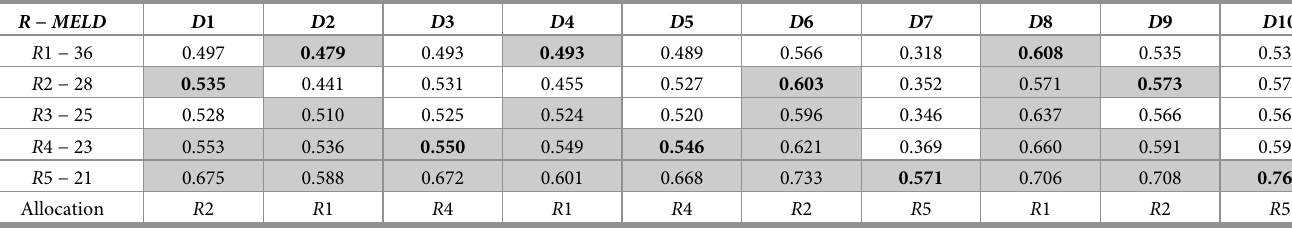
Table 8. Third simulation of D-R allocation by the LR best model (extended criteria